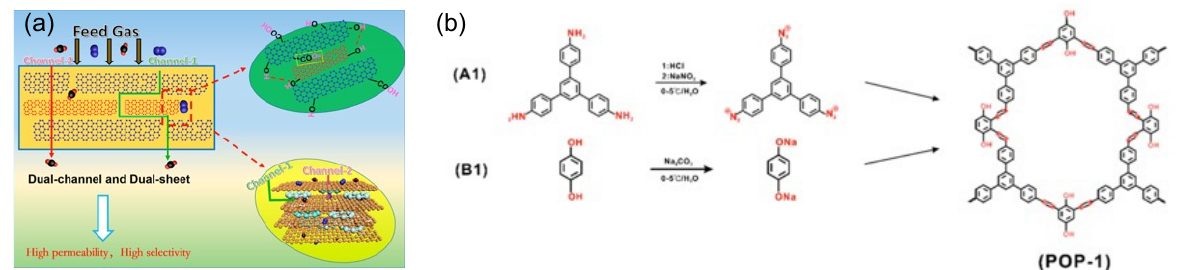
Figure 13. ( a ) Schematic illustration of design of POP-PGO-Pebax MMMs. ( b ) Chemical structure and synthesis procedure of o-POP. Reprinted with permission from [196], copyright 2019 ACS.